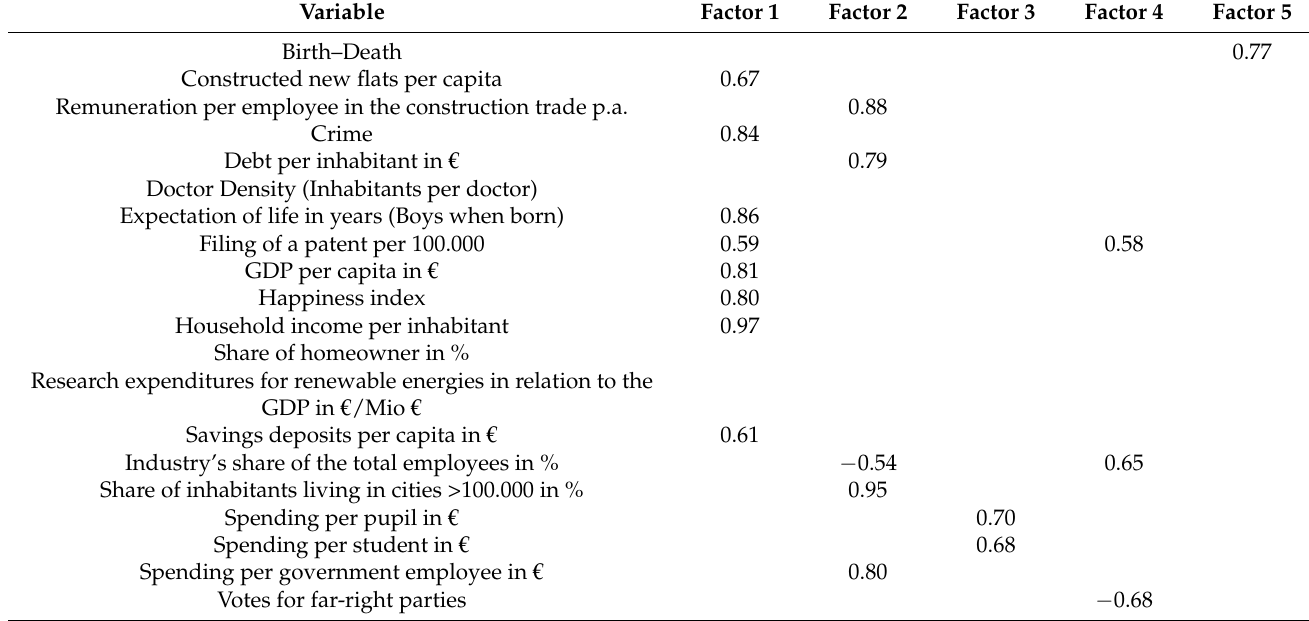
Table 4. Factor loadings for the extracted factors (varimax